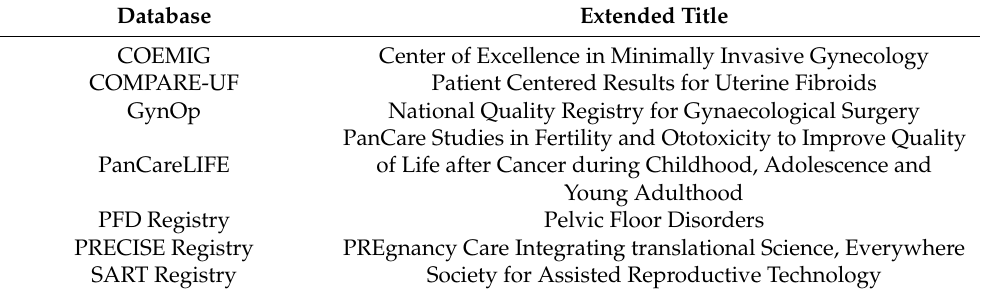
Table 3. An overview of major big data-based databases useful for gynecologists and scholars working in the field of human female reproductive